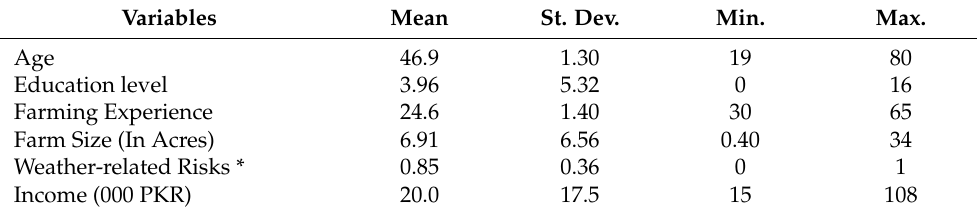
Table 5. Distribution of socioeconomic characteristics of the respondents. Variables Mean St. Dev. Min. Max. Age 46.9 1.30